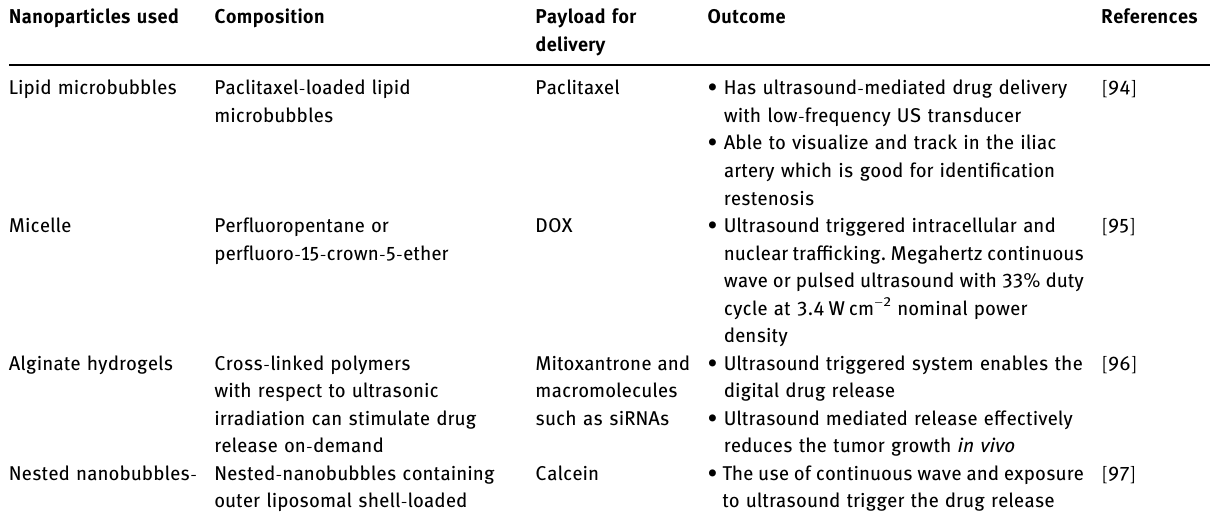
Table 5: Ultrasound responsive DDS for mono and combination cancer therapy Nanoparticles